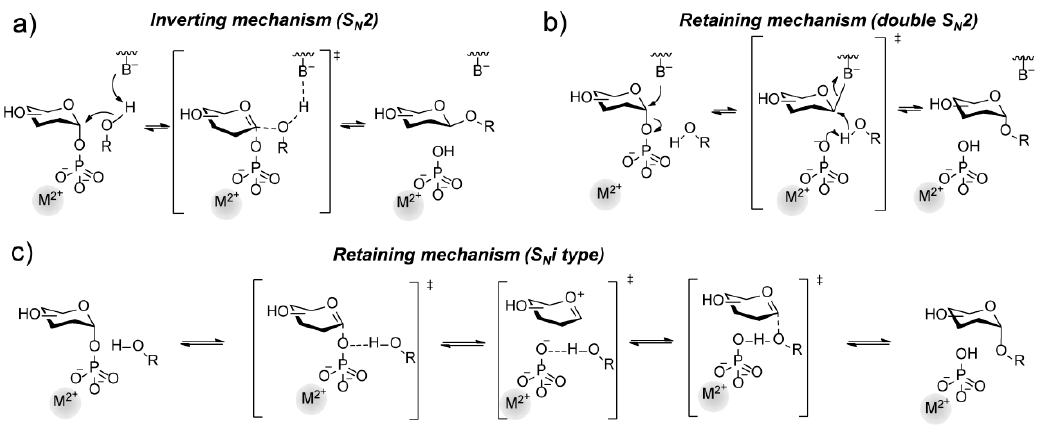
Figure 4. Reaction mechanism of glycosyltransferases upon inversion ( a ) or retention ( b , c ) of the anomeric glycosidic bond. The divalent metal (M 2+ ) is not necessarily a requirement for catalytic activity for GTs.